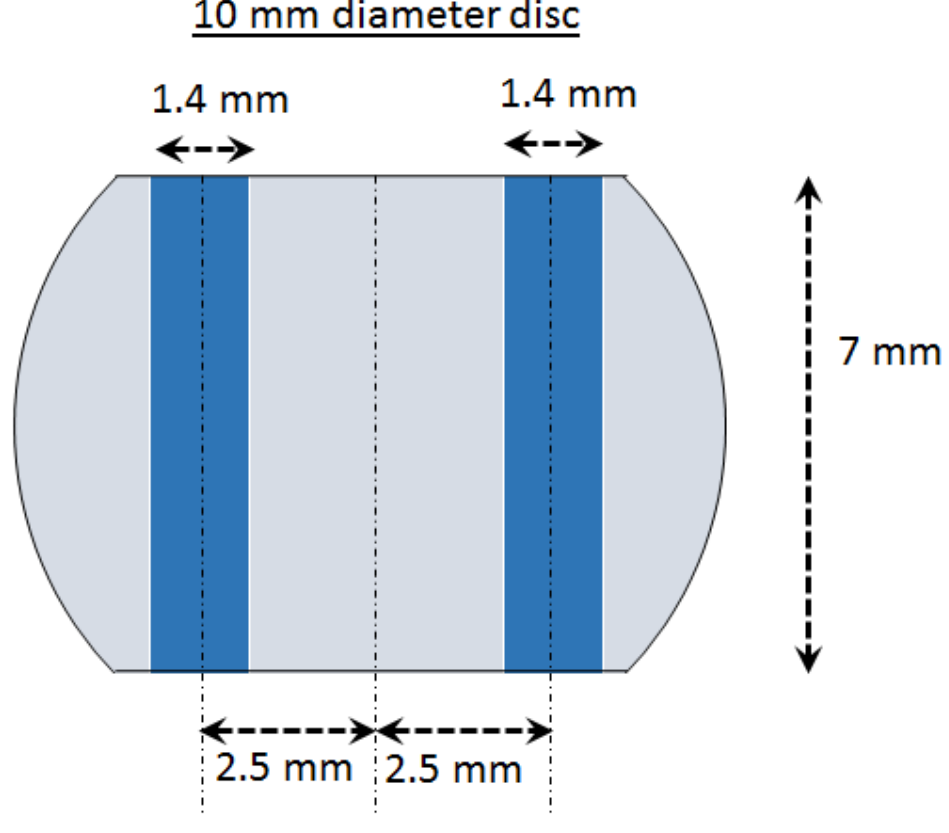
Figure 3. Illustration of the geometry of the specimens prepared from HPT-processed discs and location of the PSC tests.